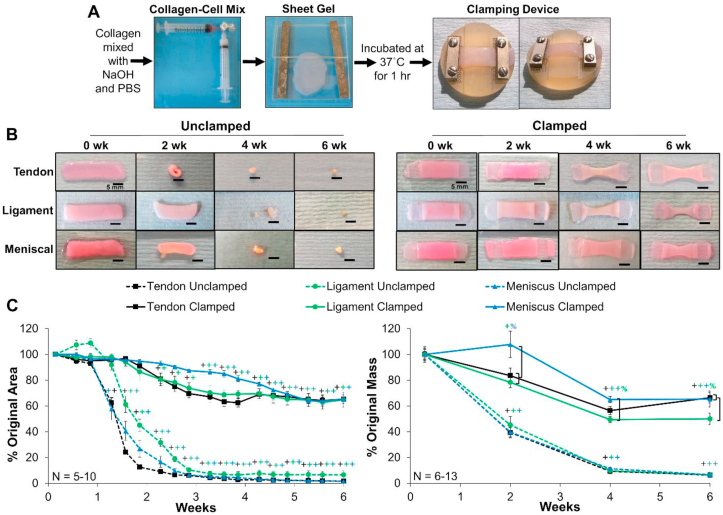
A) Cell-seeded collagen sheet gel formation and application of mechanical constraints of clamped constructs. B) Photographs of unclamped and clamped samples throughout culture and C) percentage of original area and mass of constructs. Unclamped samples significantly contracted from day 9 on, while clamped samples maintained their size through ~2–3 weeks. Scale bar = 5 mm, Data shown as mean ± S.E.M., Significance compared to +0 week and %bracket group (p < 0.05). (For interpretation of the references to color in this figure legend, the reader is referred to the Web version of this article.)